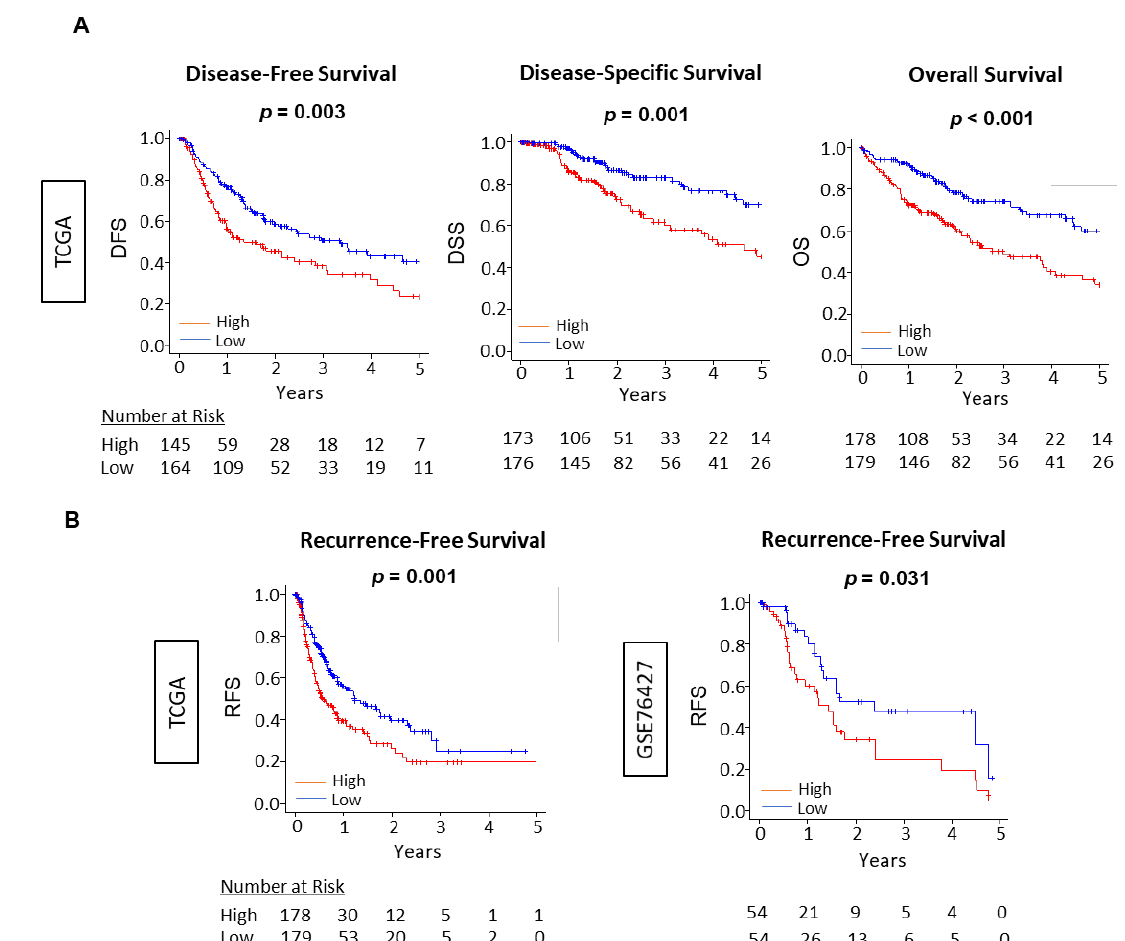
Figure 6. Association between the Unfolded Protein Response and HCC patient survival. ( A ) Kaplan–Meier survival curves comparing the low and high unfolded protein response score in HCC to demonstrate disease-free survival, disease-specific survival, and overall survival in the TCGA cohort ( n = 358). ( B ) Kaplan–Meier survival curves comparing the low and high unfolded protein response score in HCC to demonstrate recurrence-free survival in the TCGA and GSE76427 ( n = 167) cohorts. We divided the cohort into low and high unfolded protein response score groups using the median value as the cut-off. The p -value was calculated using a log rank test.